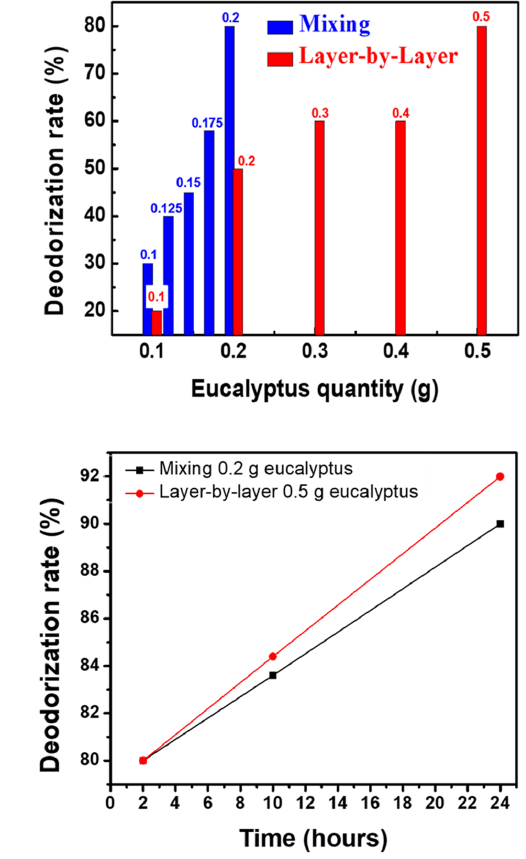
Figure 4. The deodorization rate plot describes the evolution of ammonium content according to the used eucalyptus microcapsule amount. As shown in ( a ), a two-hour deodorization rate test was conducted for layer-by-layer with various eucalyptus microcapsule amount (0.1 to 0.5 g) and mixing with eucalyptus microcapsule amount from 0.1 to 0.2 g. The optimized eucalyptus microcapsule amount was further used to conduct a 24 h deodorization test, as shown in ( b ).